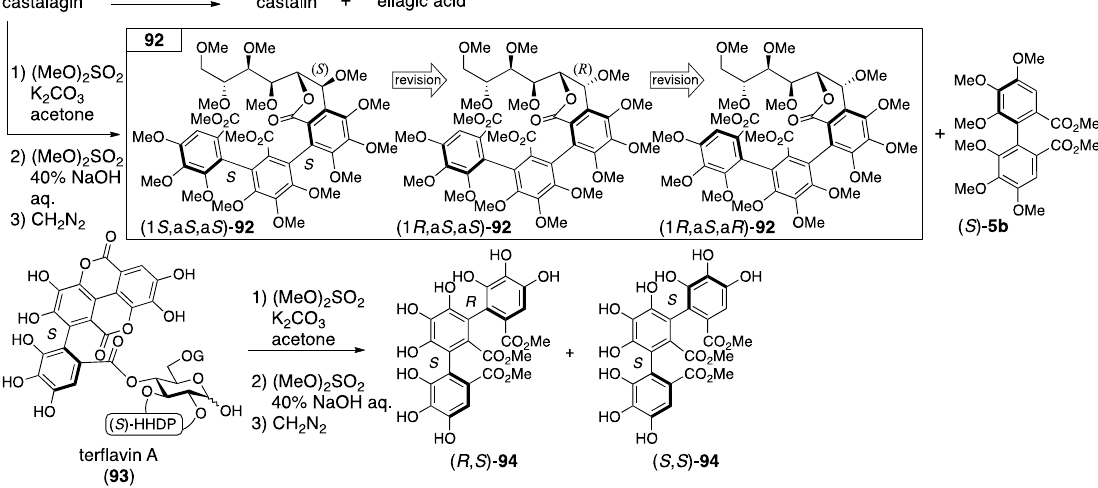
Figure 35. The hydrolysis of castalagin, and the determination of the axial chiralities in the second structure of castalagin.